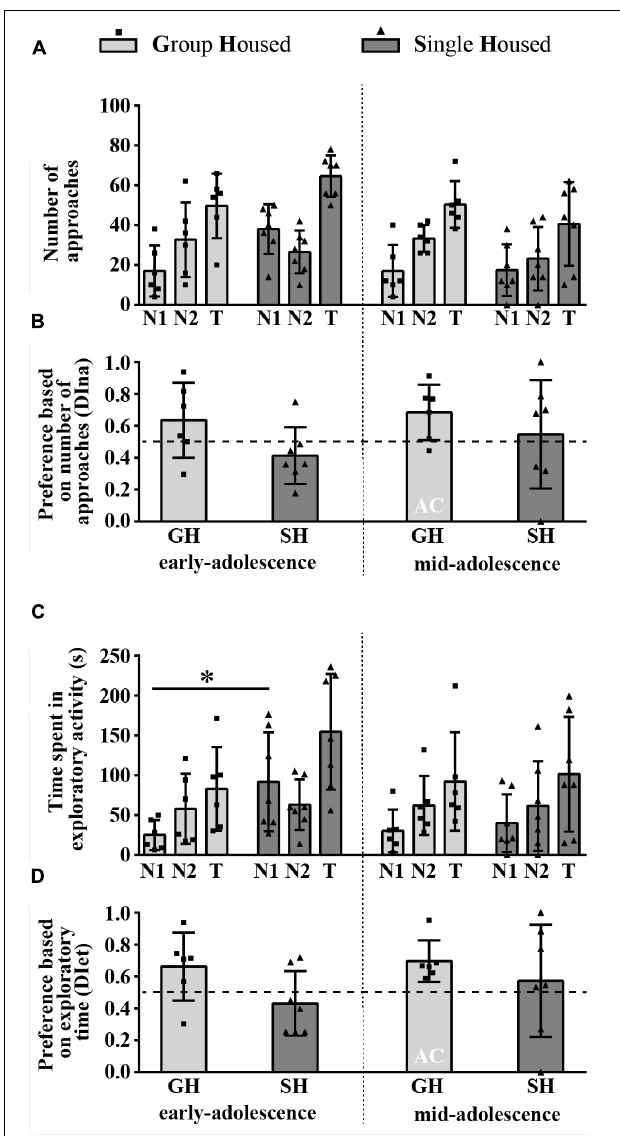
FIGURE 6 | Social novelty preference of peripubertal male rats in the 3-chamber test at the end of the first week (early-adolescence) and the second week (mid-adolescence) of defined housing, which began on the 29th postnatal day. The data are represented as mean ± SD, with individual data plots along the column bars. (A) The number of approaches to the N1 and the N2 and the total number of approaches (T); (B) Discrimination index based on the number of approaches (DIna), addressing the “wanting” aspect of the preference for the N2 over the N1, i.e., social novelty preference; (C) Time spent in the exploration of the N1 and the N2 and the total exploratory time; (D) Discrimination index based on exploratory time (DIet), addressing “liking” aspect of the preference for the N2 over the N1, i.e., social novelty preference. AC – significantly above the chance level (0.5); ∗ p ≤ 0.05 (single housed vs. group housed within the same maturational period). Statistical comparisons and exact p -values are given as Supplementary Table S1 .